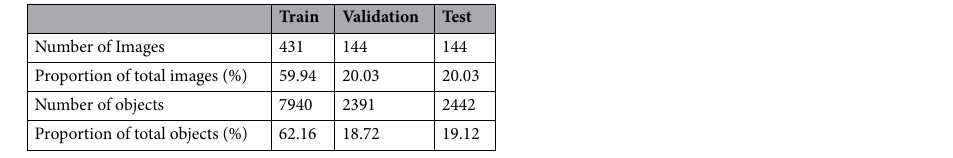
Table 5. Number of images of objects used in training, validation, and